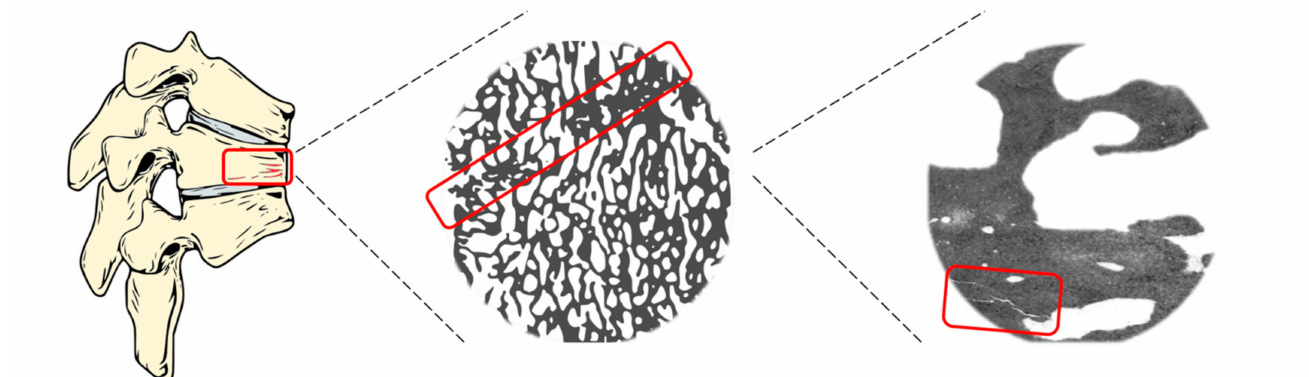
Figure 3. Schematic representation of the multiscale fracture mechanism (rectangular boxes). The macro-scale ( a ) is represented by a fractured vertebral body due to bone loss that amplifies the spine curvature. At the meso-scale ( b ), the fractured trabeculae are visible. At the micro-scale ( c ), the micro-crack starts from porosities and is deviated by the presence of the